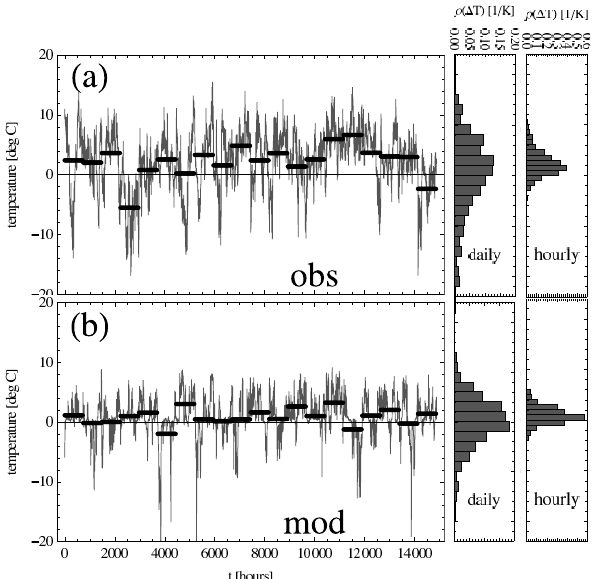
Fig. 9. Hourly time series of 20 Januaries for observations – (a) , gray – and model – (b) , gray. Black horizontal lines indicate monthly averages. Histograms of daily anomalies (relative to the monthly mean, central column) and hourly anomalies (relative to the daily mean, right column).